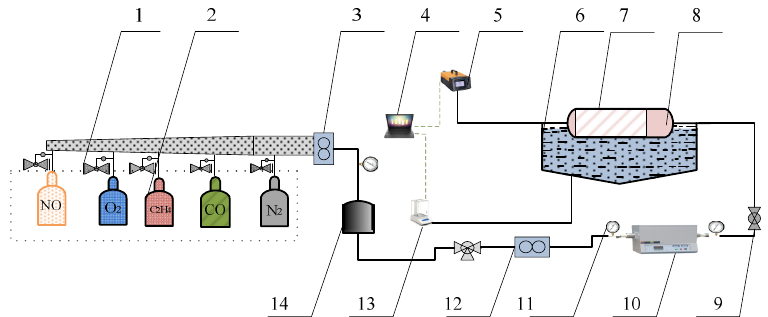
Figure 2. The overall structure of the simulation test bench. 1. Pressure-reducing valve. 2. Gas cylinder group. 3,12. Flowmeter. 4. Computer. 5. Gas analyzer. 6. Water bath pot. 7. Quartz tube. 8. Cordierite loaded with PM and catalytic agent. 9. Ball valve. 10. Tube furnace. 11. Pressure gauge. 13. Electronic balance. 14. Gas mixing